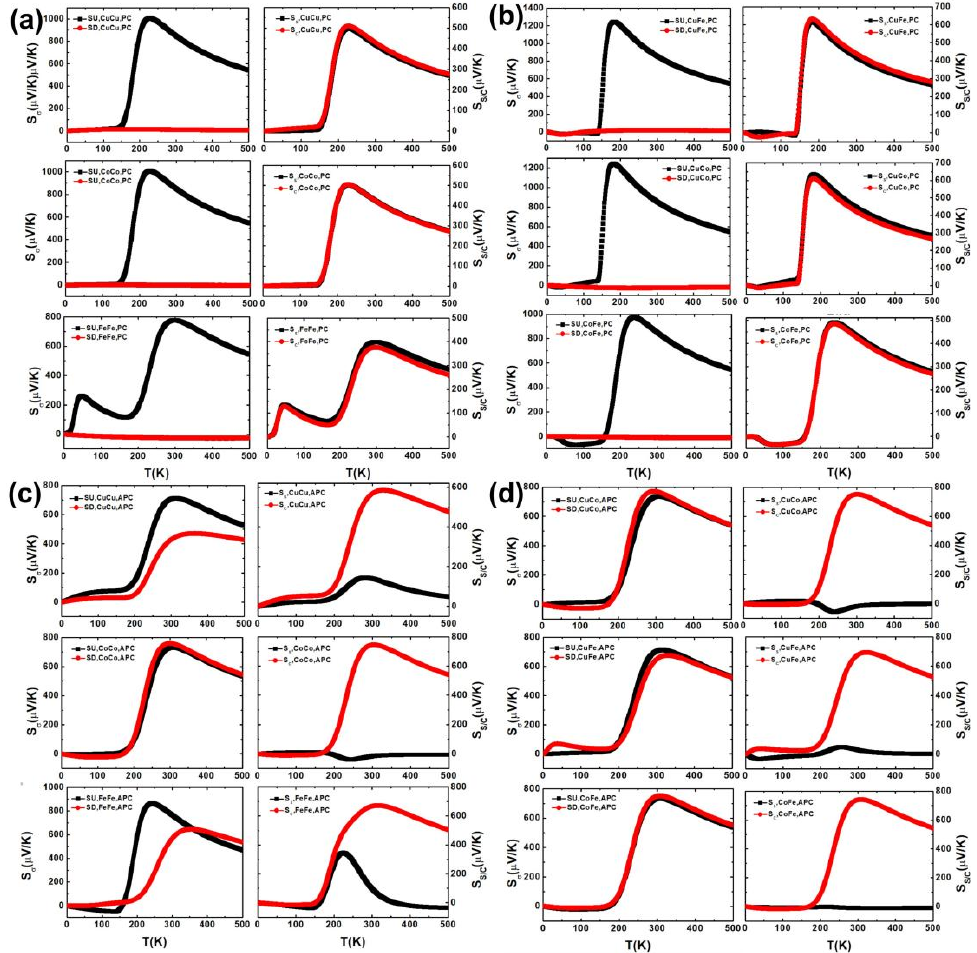
Figure 7. The spin-dependent Seebeck coefficient S σ , charge Seebeck coefficient S C and the spin Seebeck coefficient S S of CuPc-CuPc, CoPc-CoPc, FePc-FePc, CuPc-CoPc, CuPc-FePc, CoPc-FePc MDs in the PC ( a , b ) and APC ( c , d ) at zero